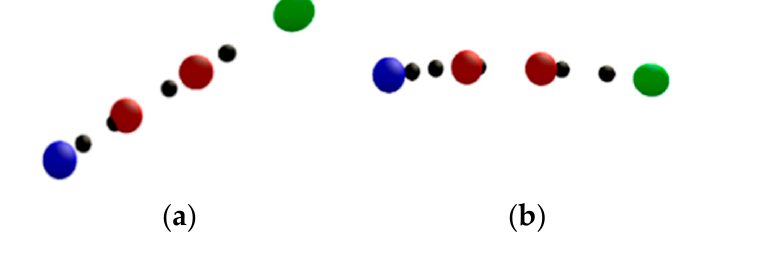
Figure 12. The data with recognition errors in “ ↗ ” and “ → ”.